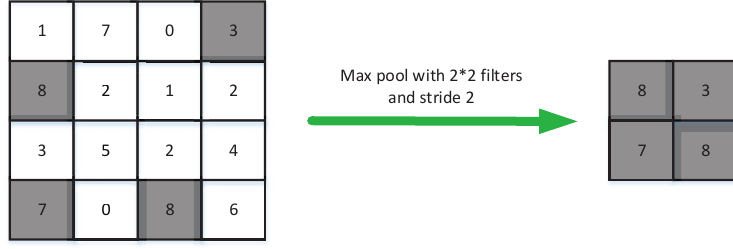
Figure 5. The computation process based on 2 × 2 Max